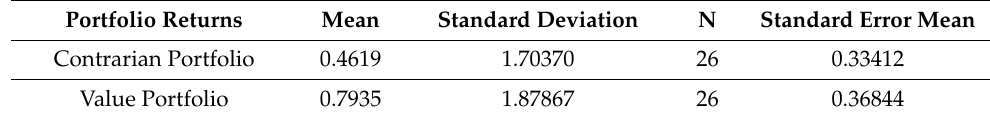
Table 9. Descriptive statistics of contrarian and value portfolio returns for year t + 4.